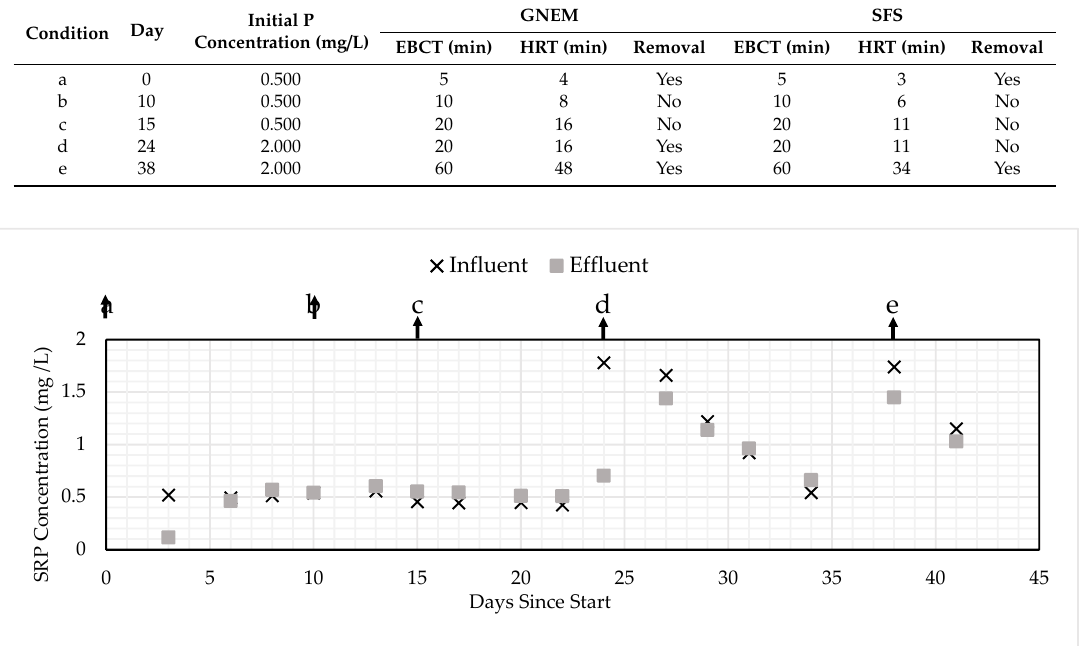
Figure 8. Comparison of phosphorous (P) removal by the monolithic and granular GNEM. 3.3. Determination of Media Volume The target influent SRP concentration for the GNEM and SFS was 0.50 mg/L. A concentration of 0.25 mg/L (50% of the target influent concentration) was selected to represent the breakthrough concentration for the economic analysis. An influent loading method was used to determine the amount of media required for site-specific conditions. The influent loading method entails correlating the effluent concentration to the cumulative mass loading (Figures 9 and 10). The equation for the linear trend line allows for the calculation of the cumulative mass of SRP loaded into the column to reach the target SRP effluent level. This method allows for variable influent flows and concentrations between the laboratory and actual system, especially for the two PSMs selected in this research, as the concentrations typically found in the subsurface drainage did not significantly change the media’s performance (Figures 6 and 7).